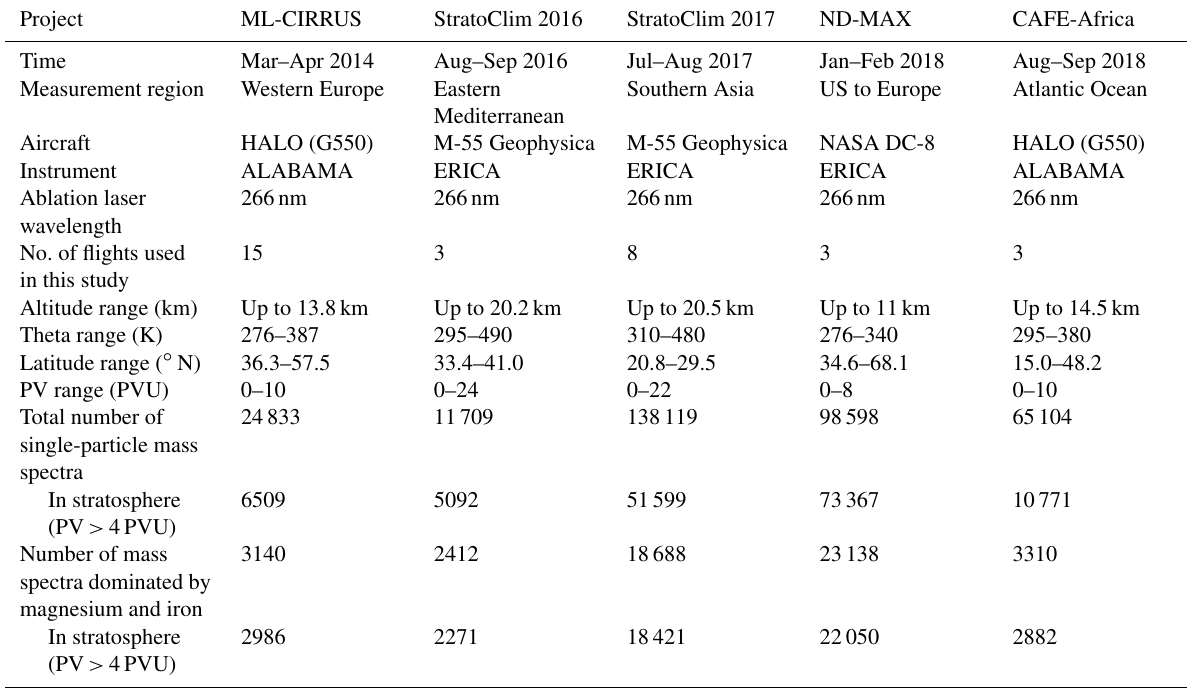
Table 1. Overview of the five different aerosol composition measurement datasets from the UTLS used in this study. PV: potential vorticity; PVU: potential vorticity